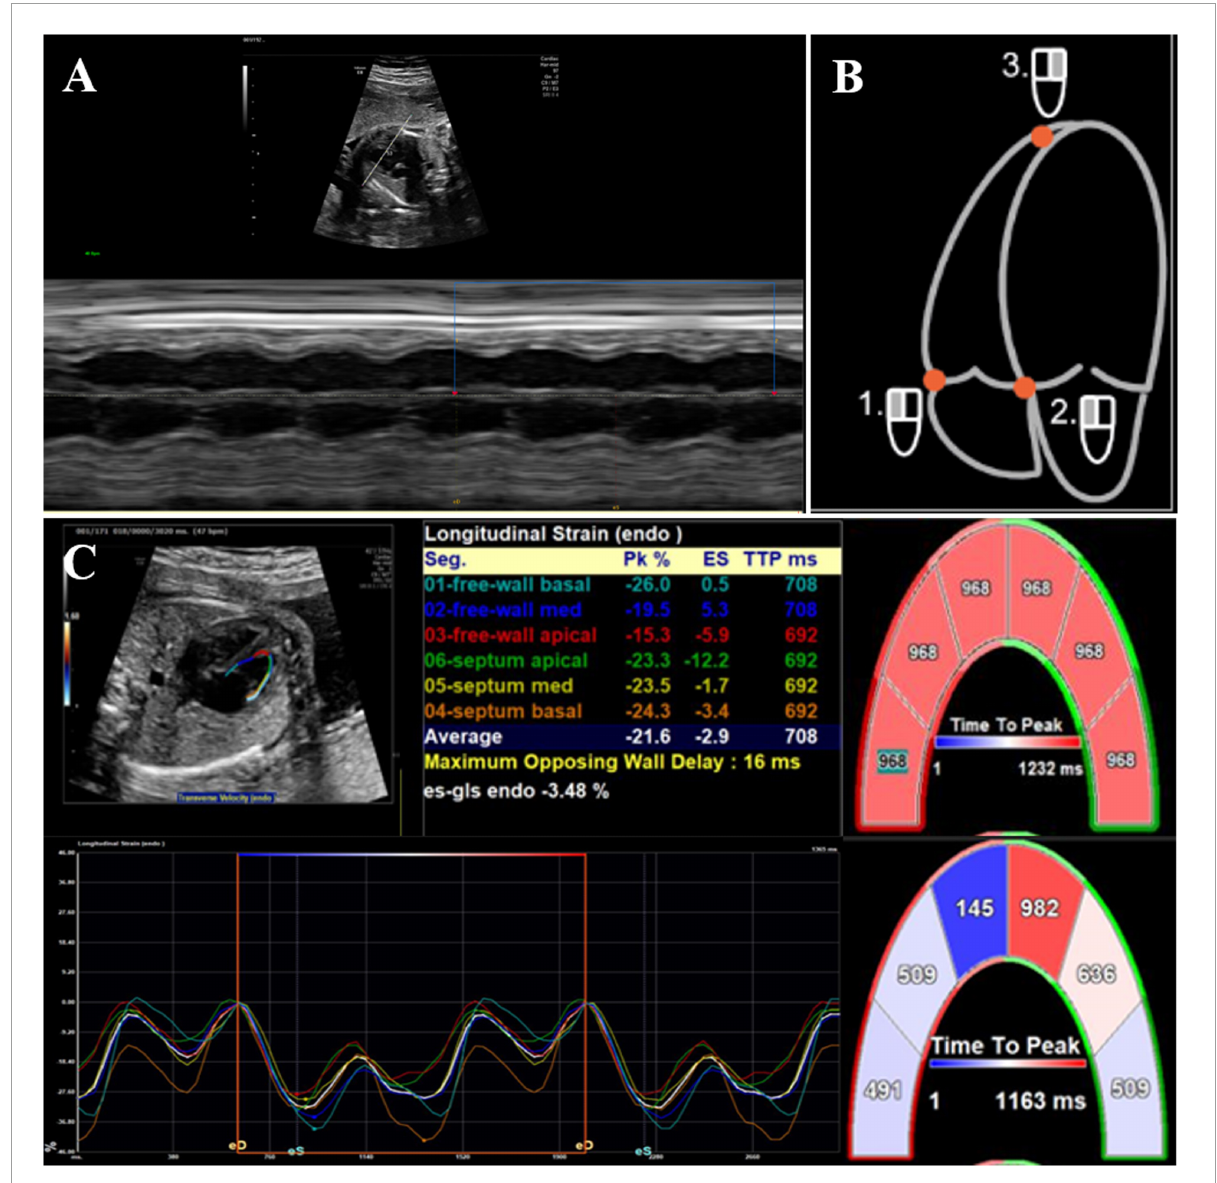
FIGURE2 2D offline analysis of fetal myocardial deformation using velocity vector imaging. (A) Superimposed manual M-mode tracing of left ventricular wall motion, used as a surrogate for fetal electrocardiographic R-wave to calculate fetal heart rate, (B) the right ventricular endocardial boundary was manually traced by three-point method, and (C) global and regional longitudinal strain values/curves were generated automatically. Each curve demonstrated segmental strain and its average